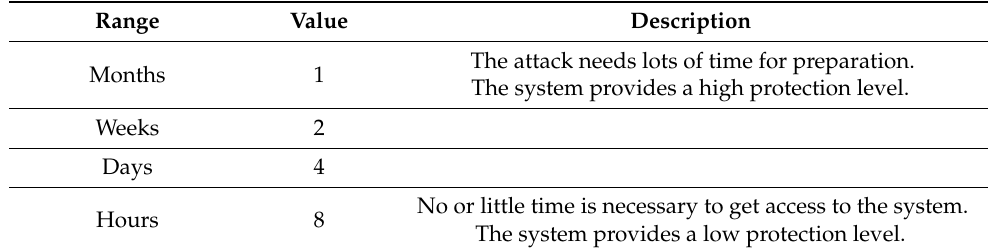
Table 7. Attack potential factor: elapsed